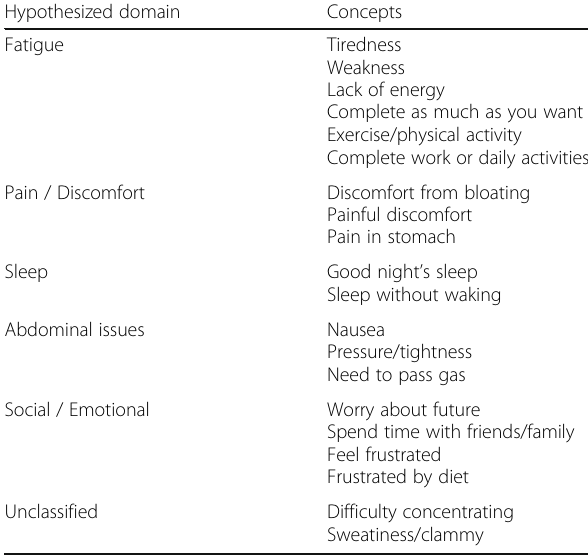
Table 6 Domains of the NASH PRO Conceptual Framework in the qualitative study (Palsgrove et al. 2016) [17] Hypothesized domain